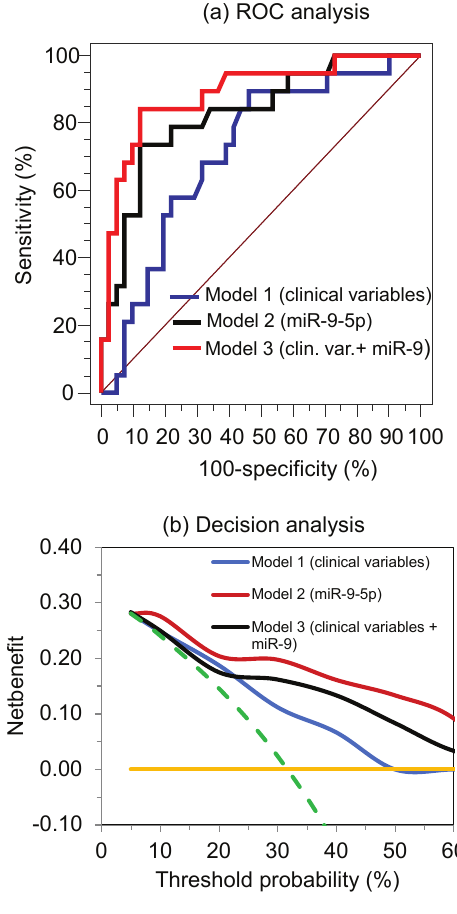
Figure 4. ROC curve analysis ( a ) and decision curve analysis ( b ) showing the benefit of miR-9-5p for predicting primary resistance to TKIs in mRCC patients in comparison to that for clinicopathological variables. Binary logistic regression models were calculated. Model 1 included the clinicopathological variables age, sex, tumor stage, Fuhrman grade, metastatic and resection status as indicated in Table 1; Model 2 considered only continuous miR-9-5p values; and Model 3 was a combination of the clinicopathological variables and miR-9-5p values (Model 1 + Model 2). Output data of binary logistic regression models were used for ROC and decision curve analyses as previously described